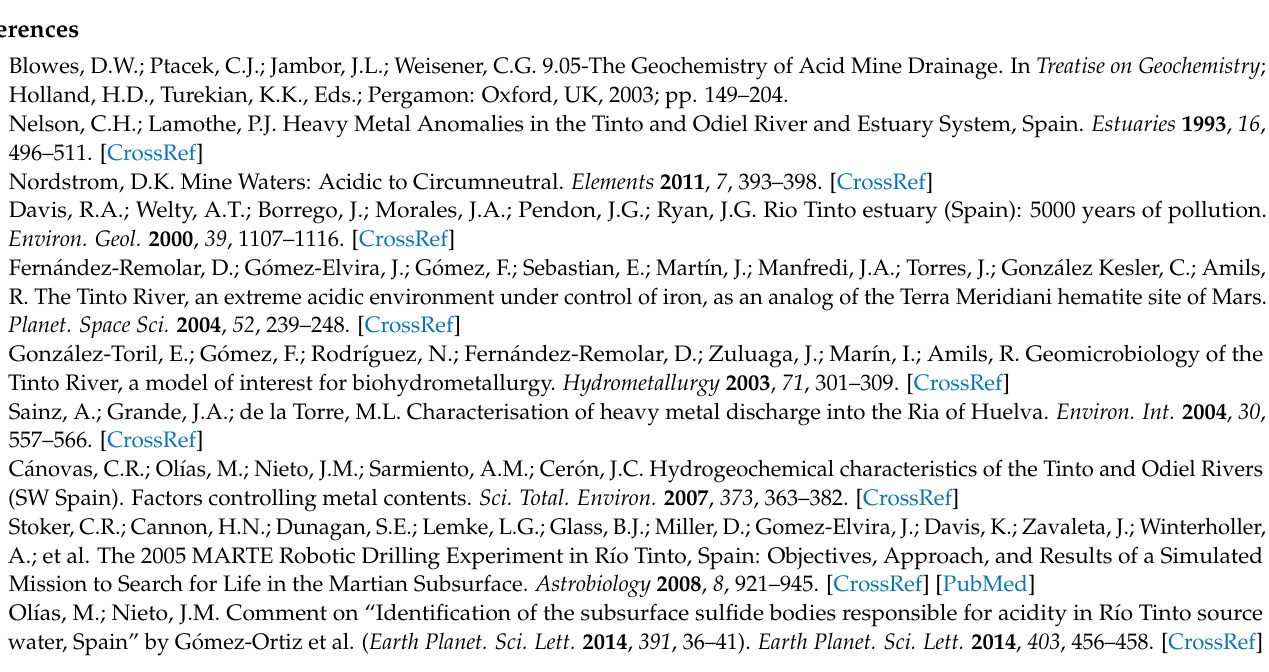
Supplementary Materials: The following are available online at https://www.mdpi.com/article/10 .3390/w13202861/s1, Figure S1: Simplified geological map of the study area showing the different lithologies, structures and sampling locations.; Figure S2: ERT (Electric Resistivity Tomography) sounding results for profiles 1 and 2 showing the underground lithological and tectonic structure; Figure S3: A GIS diagram displaying proportional symbols which represent the total cations from each of the springs; Figure S4: GIS diagram of the study area, with proportional symbols representing concentrations of specific elements in mg/L as aluminum (a), cobalt (b), calcium (c), manganese (d), zinc (e), and iron (f); Figure S5: Different GIS maps which representing the total anion composition (a), Sulfate (b), phosphate (c), and fluorine (d) for each locality in a proportional symbology format; Figure S6: Rainwater and spring δ 18 O and δ 2 H in the study area. (a) δ 18 O values for the Rio Tinto springs, with the average δ 18 O value for the rainwater on the 24 June 2014 and data from GNIP spanning 2000–2006; (b) δ 2 H values for the Rio Tinto springs with an average δ 2 H value for the rain collected on the 24 June 2014 and an average of GNIP data from 2000–2006; Table S1: Tables summarizing the accuracy of the isotopic analysis in relation to the standards, IA-RO52, IA-RO53 and IA-RO54, and the standards used in the isotopic analysis; Table S2: Rainwater average isotope data 2000–2006 for Seville. Weighted values are used to correct biases in the 2H concentration by re-evaporation processes; Table S3: Table summarizing the acid producing minerals within the VSC deposit of Rio Tinto and the acidity of each, complemented by their reaction rates through Fe 3+ ; Table S4: Summarizing the PHREEQC results, with N/A assuming the mineral does not form under those conditions or that the elements are in large enough concentrations to form sufficient mineral. Standard state conditions were used within the input